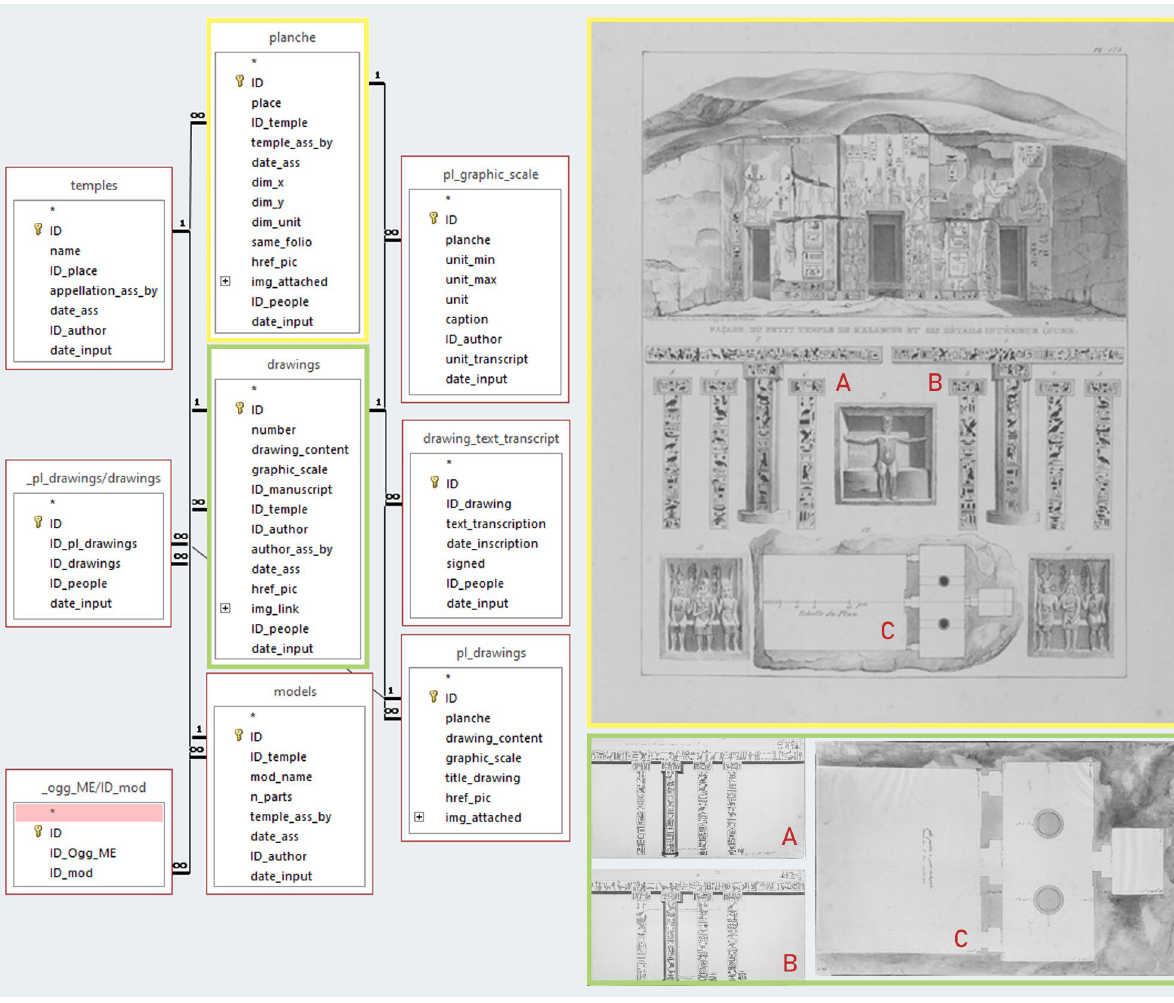
Figure 7. database relationship structure for planches and